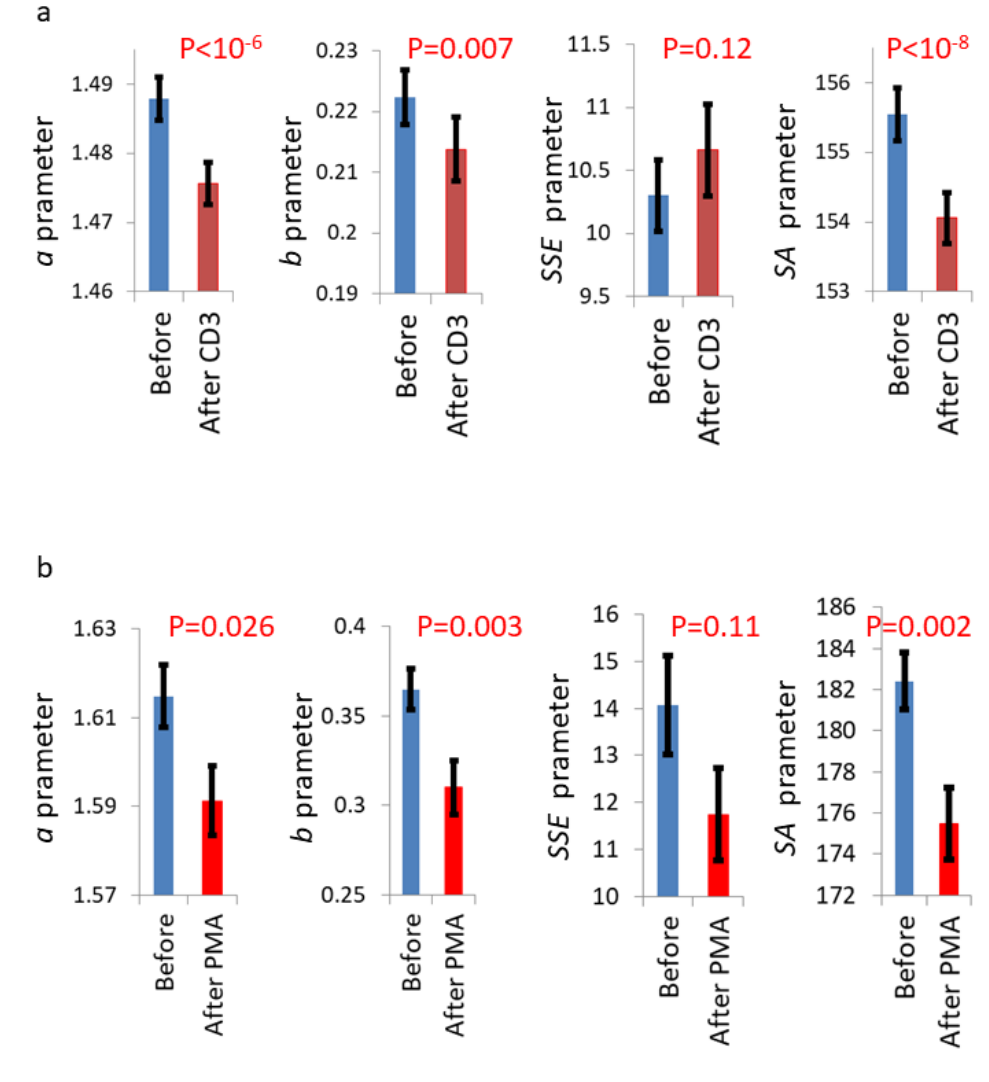
Figure 14. GLIE fluctuation parameters in primary T cells before and after stimulation with anti-CD3 or with PMA. ( a ) GLIE fluctuation parameters before and after incubation with anti-CD3 (n = 193). ( b ) GLIE fluctuation parameters before (n = 131) and after (n = 102) incubation with PMA. Error bars are SEM; p -values are presented in the corresponding